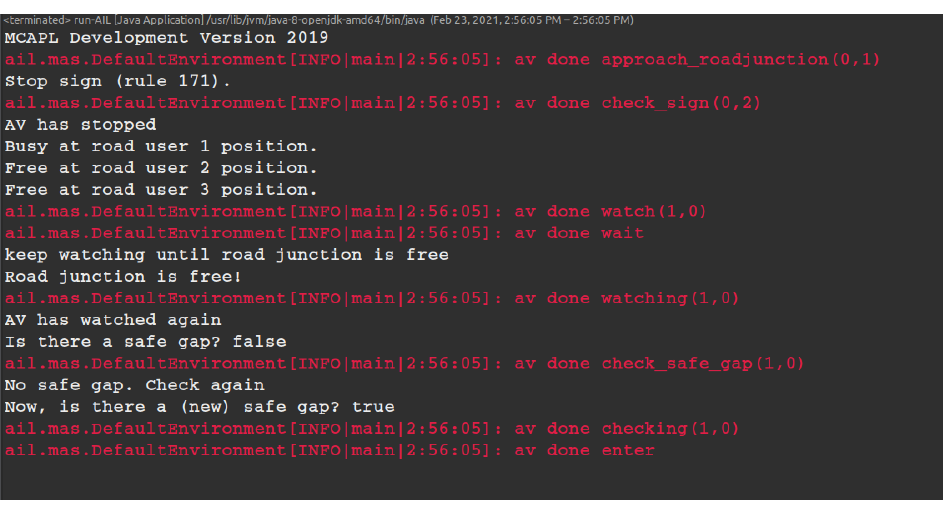
Figure 8. Scenario 2: output